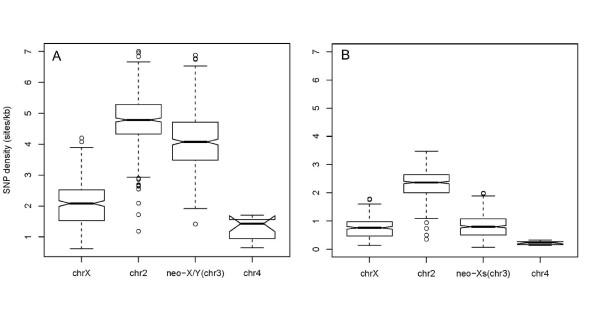
Patterns of heterozygosity across chromosomes. SNP densities along each chromosome were calculated within a 1 Mb window with a step size of 100 kb. (A) SNP densities calculated based on mapping of male reads. (B) SNP densities calculated based on mapping results of female reads.